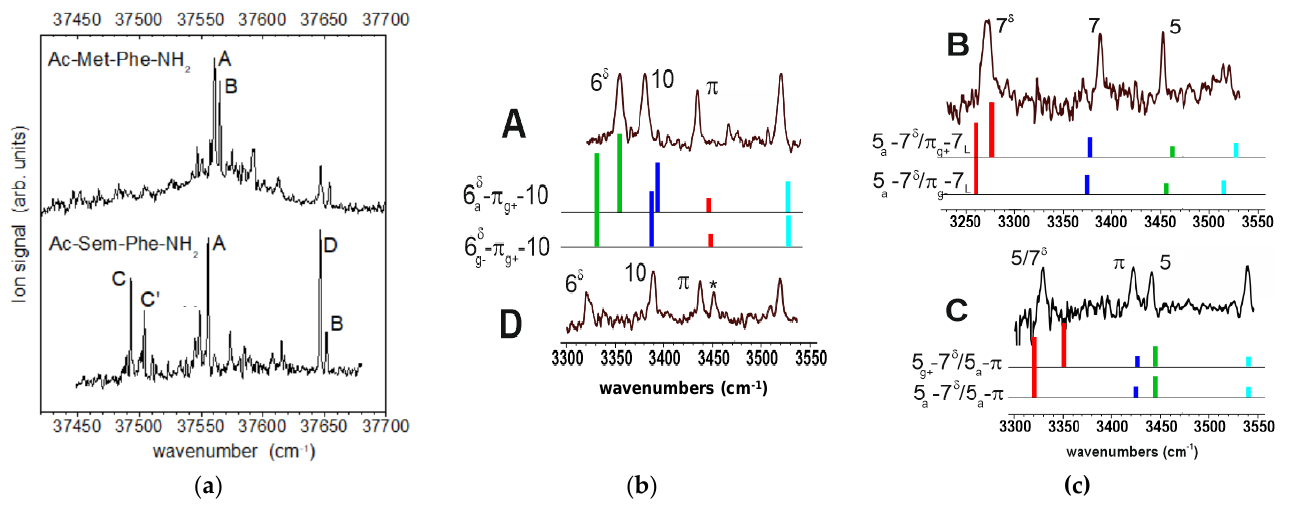
Figure 3. (a ) left panel: Near UV spectrum of the Ac-Sem-Phe-NH 2 molecule in the origin region of first ππ*transition of Phe, as obtained by mass -selected R2PI. Top : For comparison, the same spectrum for the related compound with Met is also shown (adapted with permission from Ref. [19]; Copyright 2012 American Chemical Society). ( b , c ) central and right panels: IR/UV double resonance spectra of conformers A – D (black traces), compared to the theoretical spectra (colored sticks) of selected best matching, low energy conformations (see Figure 2): A and D are assigned to folded 6 δ - π -10 conformations; B and C to extended 5-7 δ /5-7 forms. The IR experimental spectra (A – D) were recorded by probing the UV band bearing the same label in Figure 1. The asterisk in spectrum D suggests a secondary contribution to the IR spectrum (see text for discussion). The color code of the stick spectra (green, red, blue and cyan bars) corresponds to NH stretches of the Sem, Phe residues and of the symmetric and antisymmetric C-terminal amide, respectively.